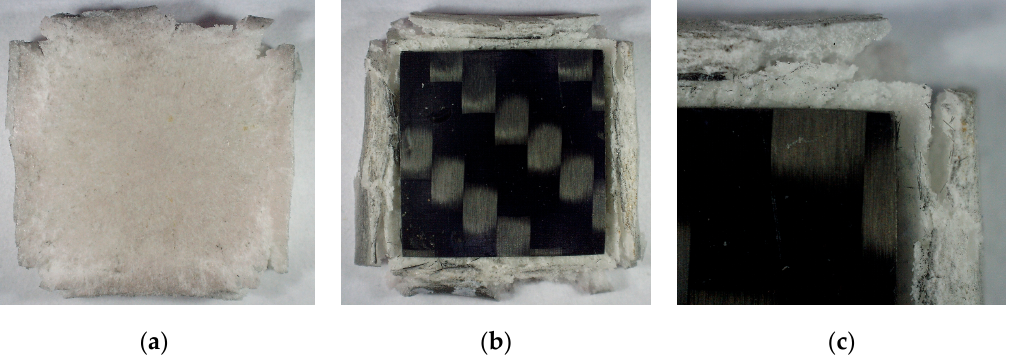
Figure 5. Sample 1_1 after static compression test: ( a ) the TBC ceramic mat, ( b ) the substrate PMC layer, and ( c ) details of damage stage after 2 mm displacement.